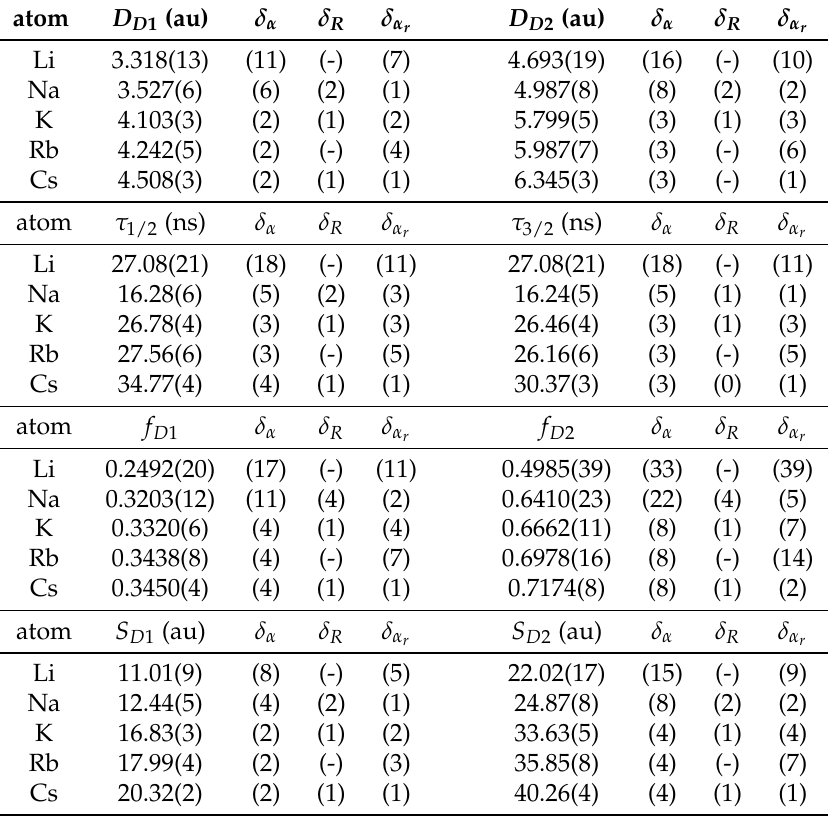
Table 2. Atomic properties inferred from experimental polarizability measurements made using atom interferometry [3–5] and theoretical residual polarizabilities [47,48]. Reduced matrix elements D D 1 = (cid:104) np 1/2 (cid:107) r (cid:107) ns 1/2 (cid:105) and D D 2 = (cid:104) np 3/2 (cid:107) r (cid:107) ns 1/2 (cid:105) , lifetimes τ np 1/2 and τ np 3/2 , oscillator strengths f , and line strengths S shown here are inferred from measurements of polarizabilities, α ( 0 ) shown in Table 1 using Equations (11)–(16). Subscripts D1 and D2 refer to the ns - np 1/2 and ns - np 3/2 transitions, respectively, where n = 6 for Cs, n = 5 for Rb, n = 4 for K, n = 3 for Na and n = 2 for Li. Uncertainty budget components δ α , δ R , and δ α come from the uncertainties in α ( 0 ) [3–5] (see Table 1), R [12,18,50–52], r and α r ( 0 ) [47,48] (see Table A1). The resulting uncertainties for D D 1 , D D 2 , τ np 1/2 , τ np 3/2 , f D 1 , f D 2 , S D 1 , and S D 2 are reported presuming possible errors δ α , δ R , and δ α are uncorrelated. The symbol (-) r indicates an uncertainty < 1 in the least significant